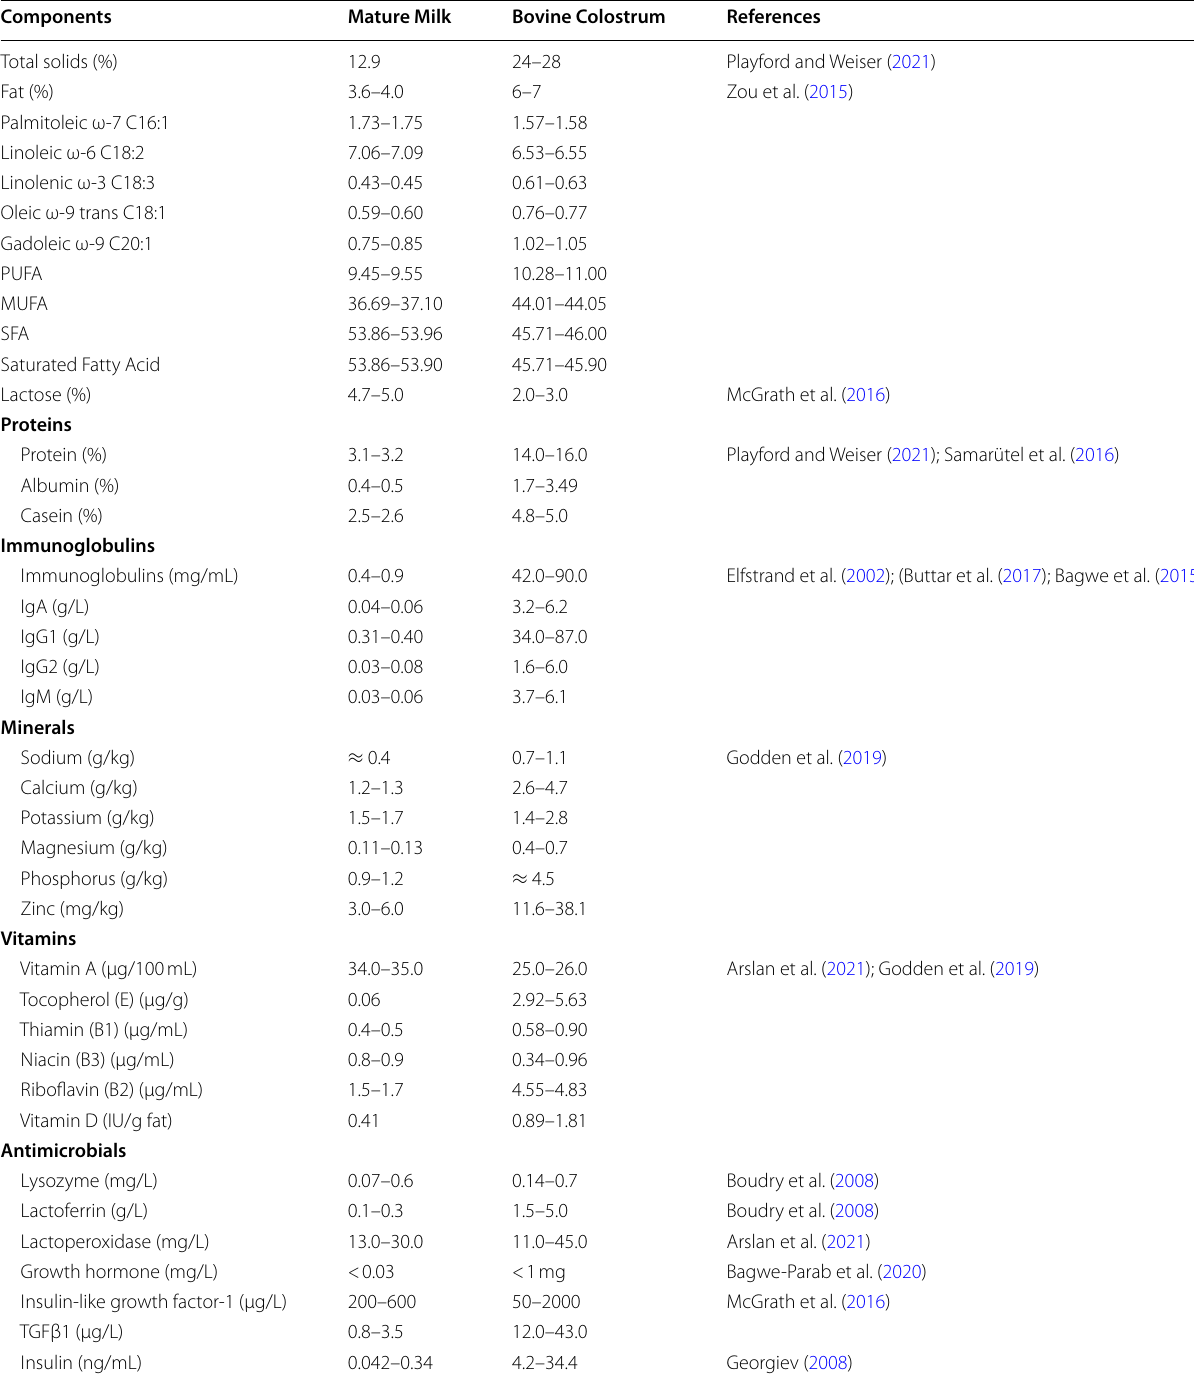
Table 1 Comparison of composition of bovine colostrum with mature